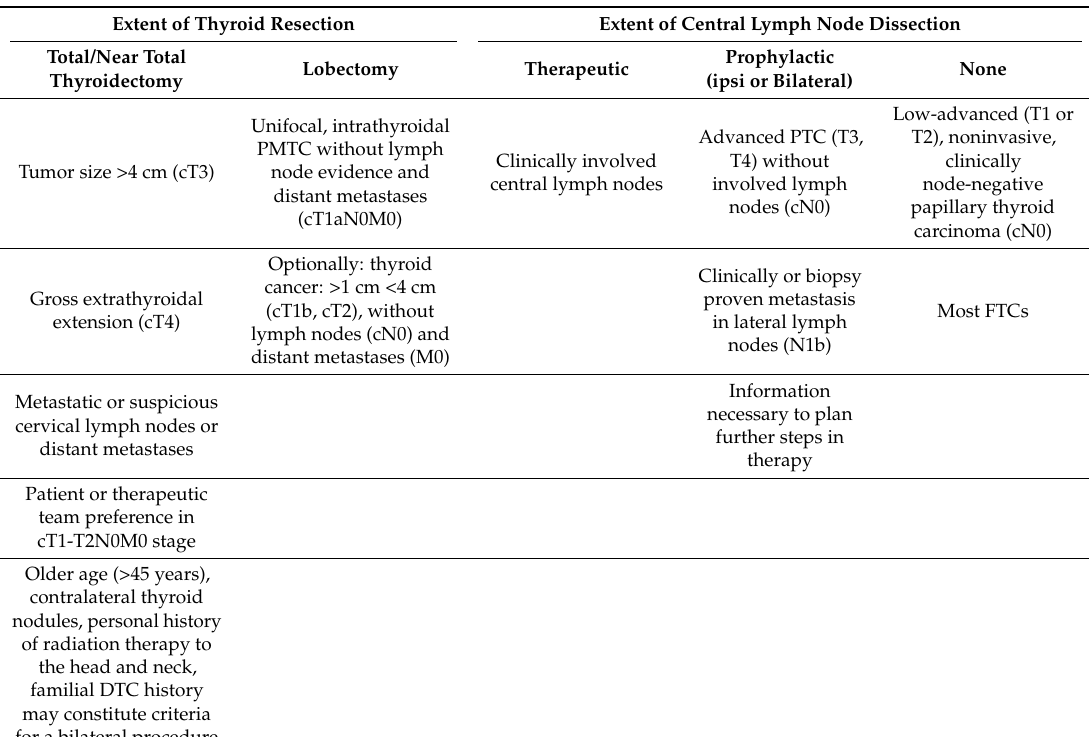
Table 2. The extent of surgery in DTC according to the current ATA guidelines